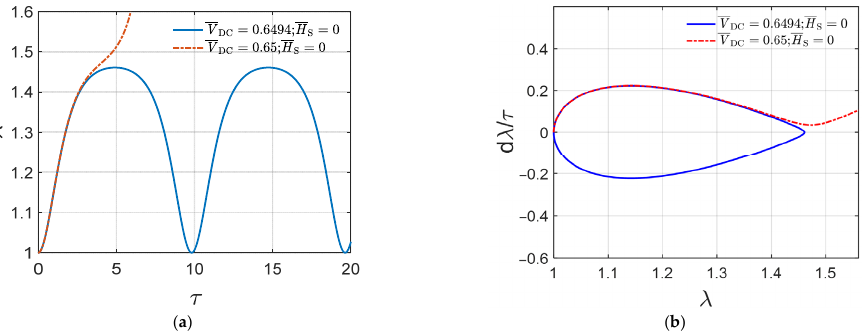
Figure 2. The DC dynamic response of the electro-magneto-active polymer to H = H S = 0and K = 0. ( a ) Time history and ( b ) phase plane diagram.